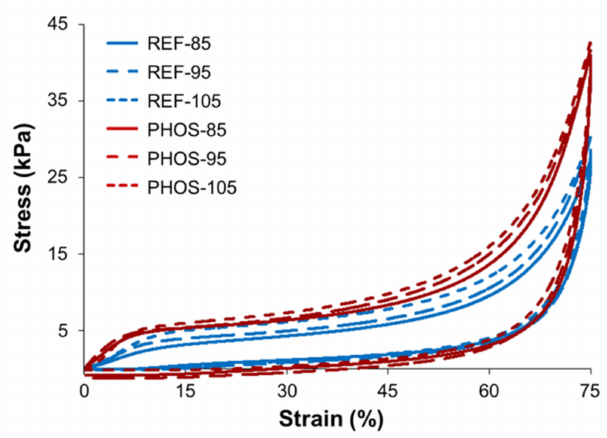
Figure 7. Hysteresis loops of flexible